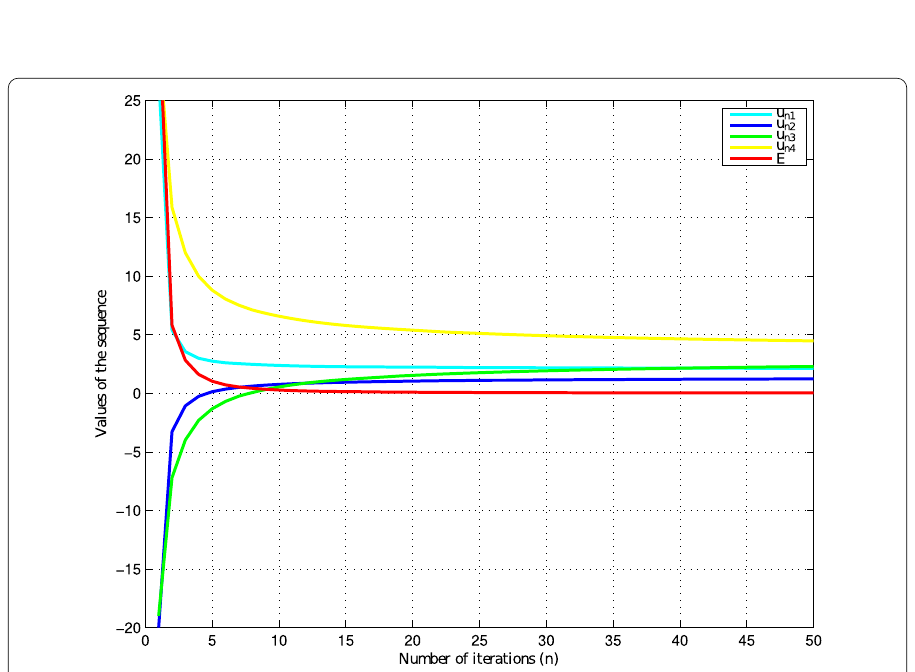
Figure 12 Convergence result of Theorem 3.11 with starting point of Case